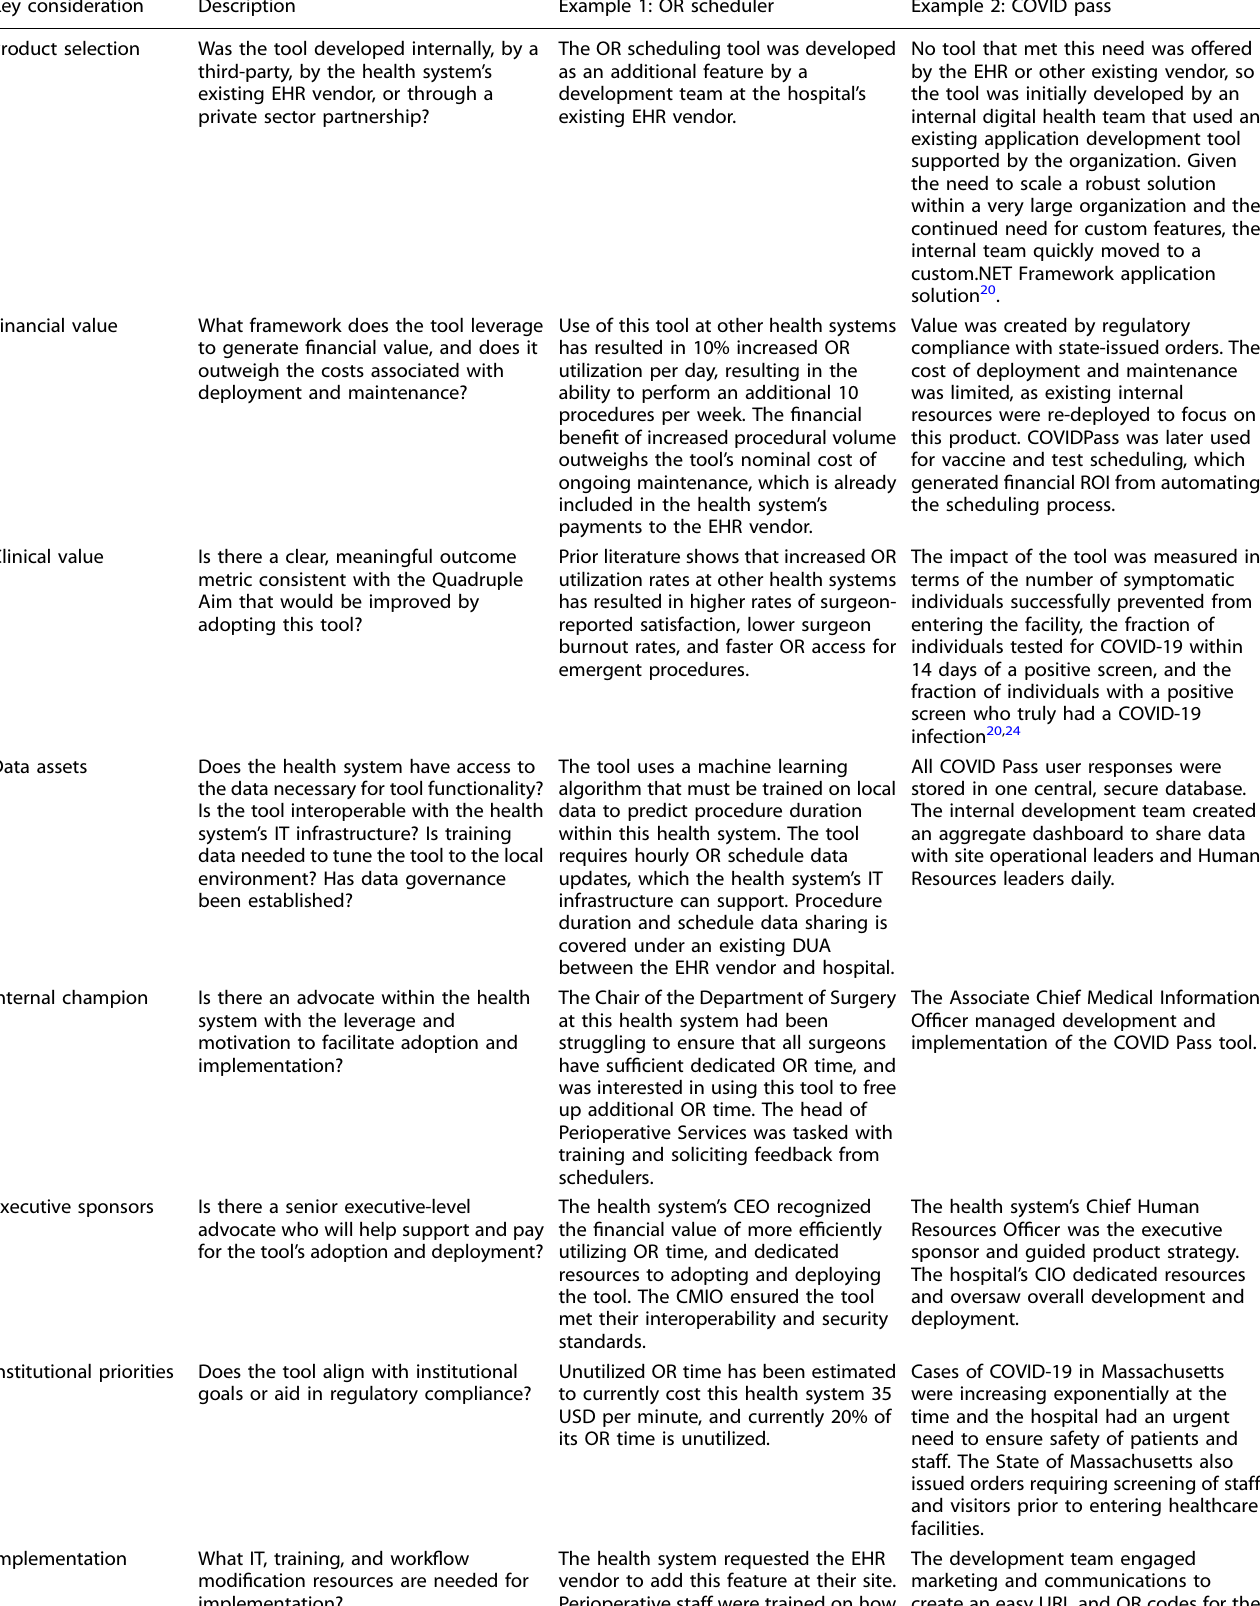
Table 1. Key considerations for digital health tool